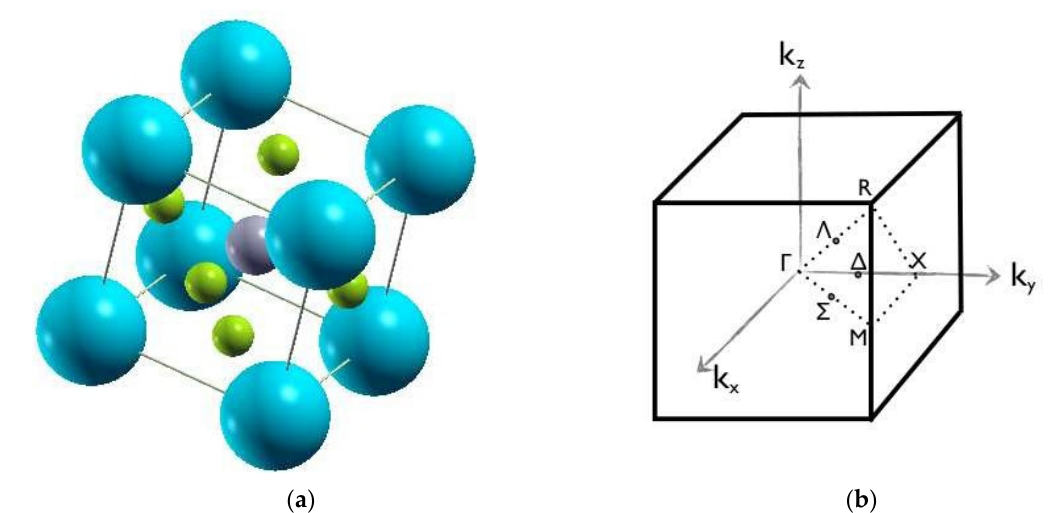
Figure 1. ( a ) Cubic structure of formal perovskites. The spheres in the figure are the atoms. The gray atom in the center represents A atoms, the green atoms represent the B atoms, and the blue atoms are the X atoms. ( b ) First Brillouin zone of cubic crystal structure [42]. High symmetry k-points are Γ (0,0,0), R (0.5, 0.5, 0.5), X (0, 0.5,. 0), and M (0.5, 0.5, 0).